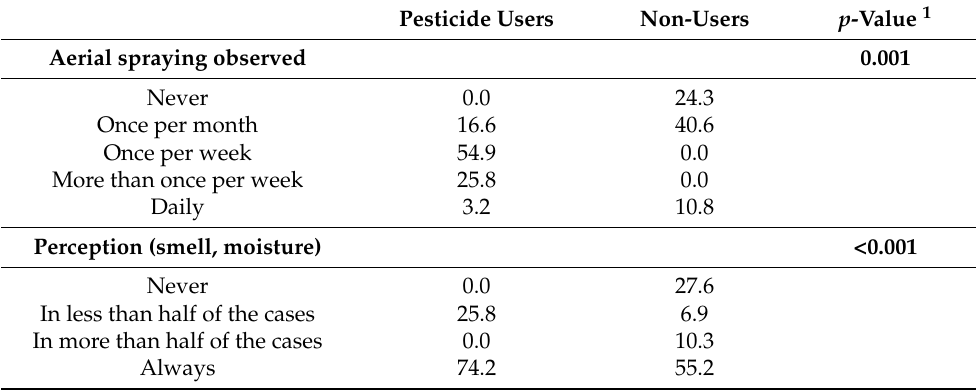
Table 3. Frequency of exposure to aerial spraying and reported residues after spraying (in %).